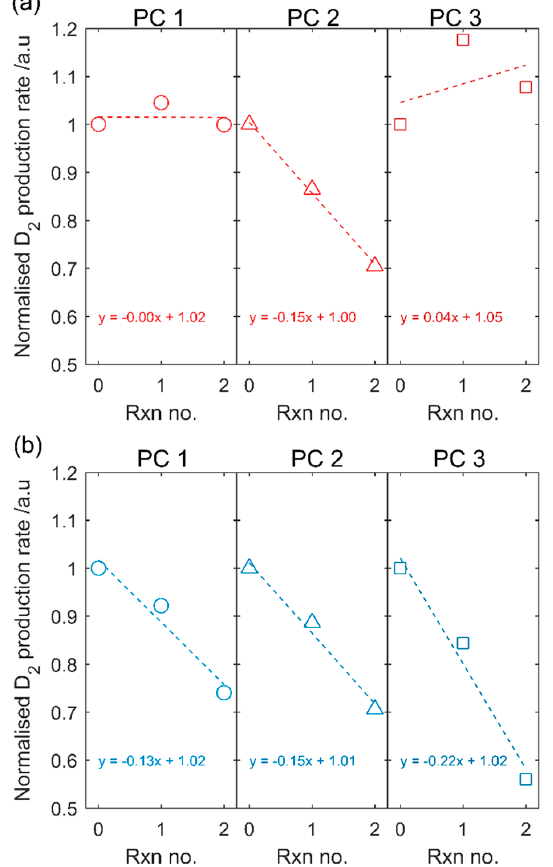
Figure 7. Recycling of photocatalytic discs for ( a ) P25-Pt-np-1 wt% and ( b ) P25-Pt-nc-2 wt%. Each graph shows normalised D 2 photocatalytic production rate for 3 repeated reactions and 3 unique photocatalytic discs (PC 1–3).